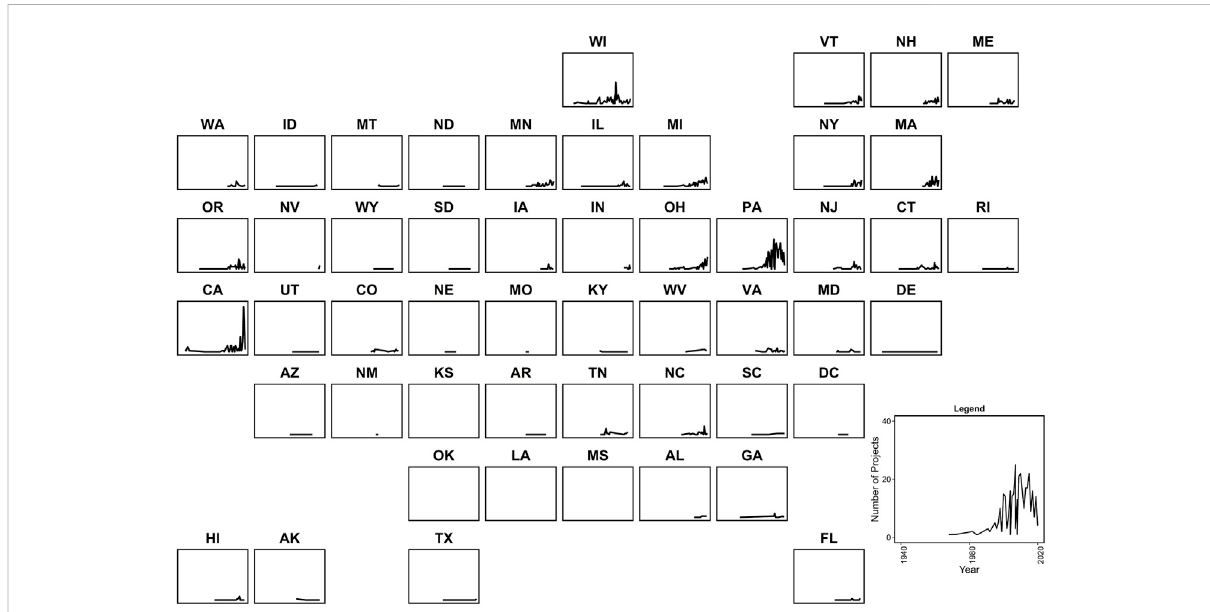
FIGURE 7 Changes in the number of dam removals among states over time, as recorded in the American Rivers dam removal database. The inset legend (bottom right) describes the axes used for all state plots, and uses data from the state of Pennsylvania (PA) as an example. State abbreviations follow ANSI two-letter codes and are arranged in each state ’ s approximate geographic